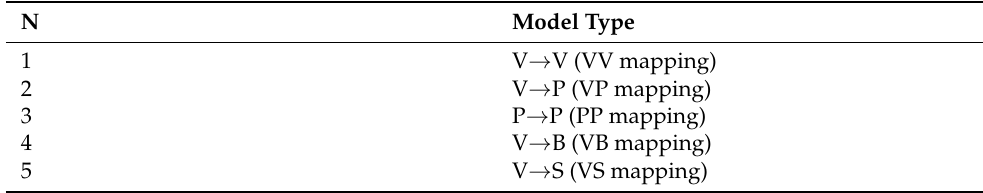
Table 1. Main types of